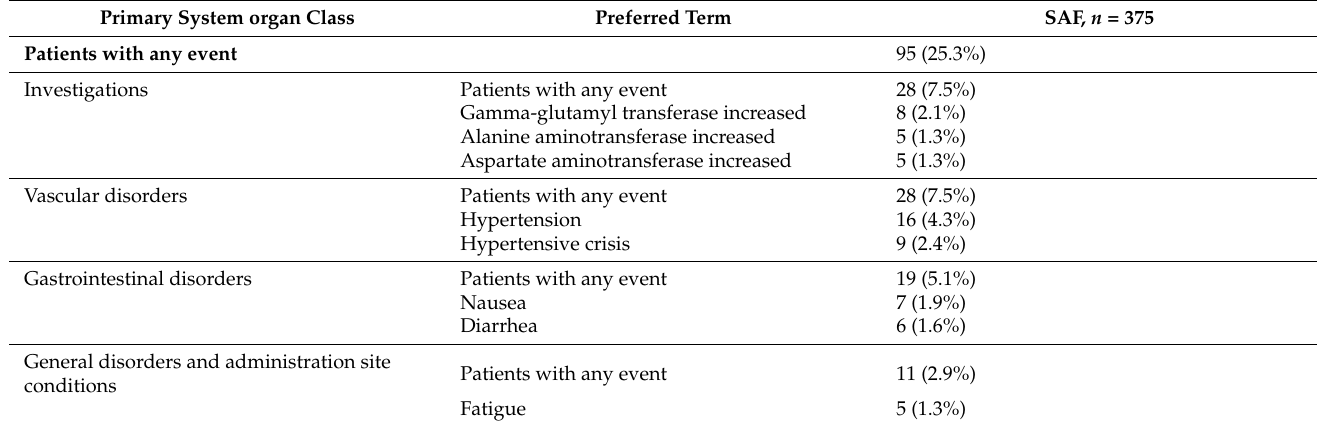
Table 4. Related TEAE of CTCAE severity grade 3/4 under first-line pazopanib occurring in at least 5 patients.